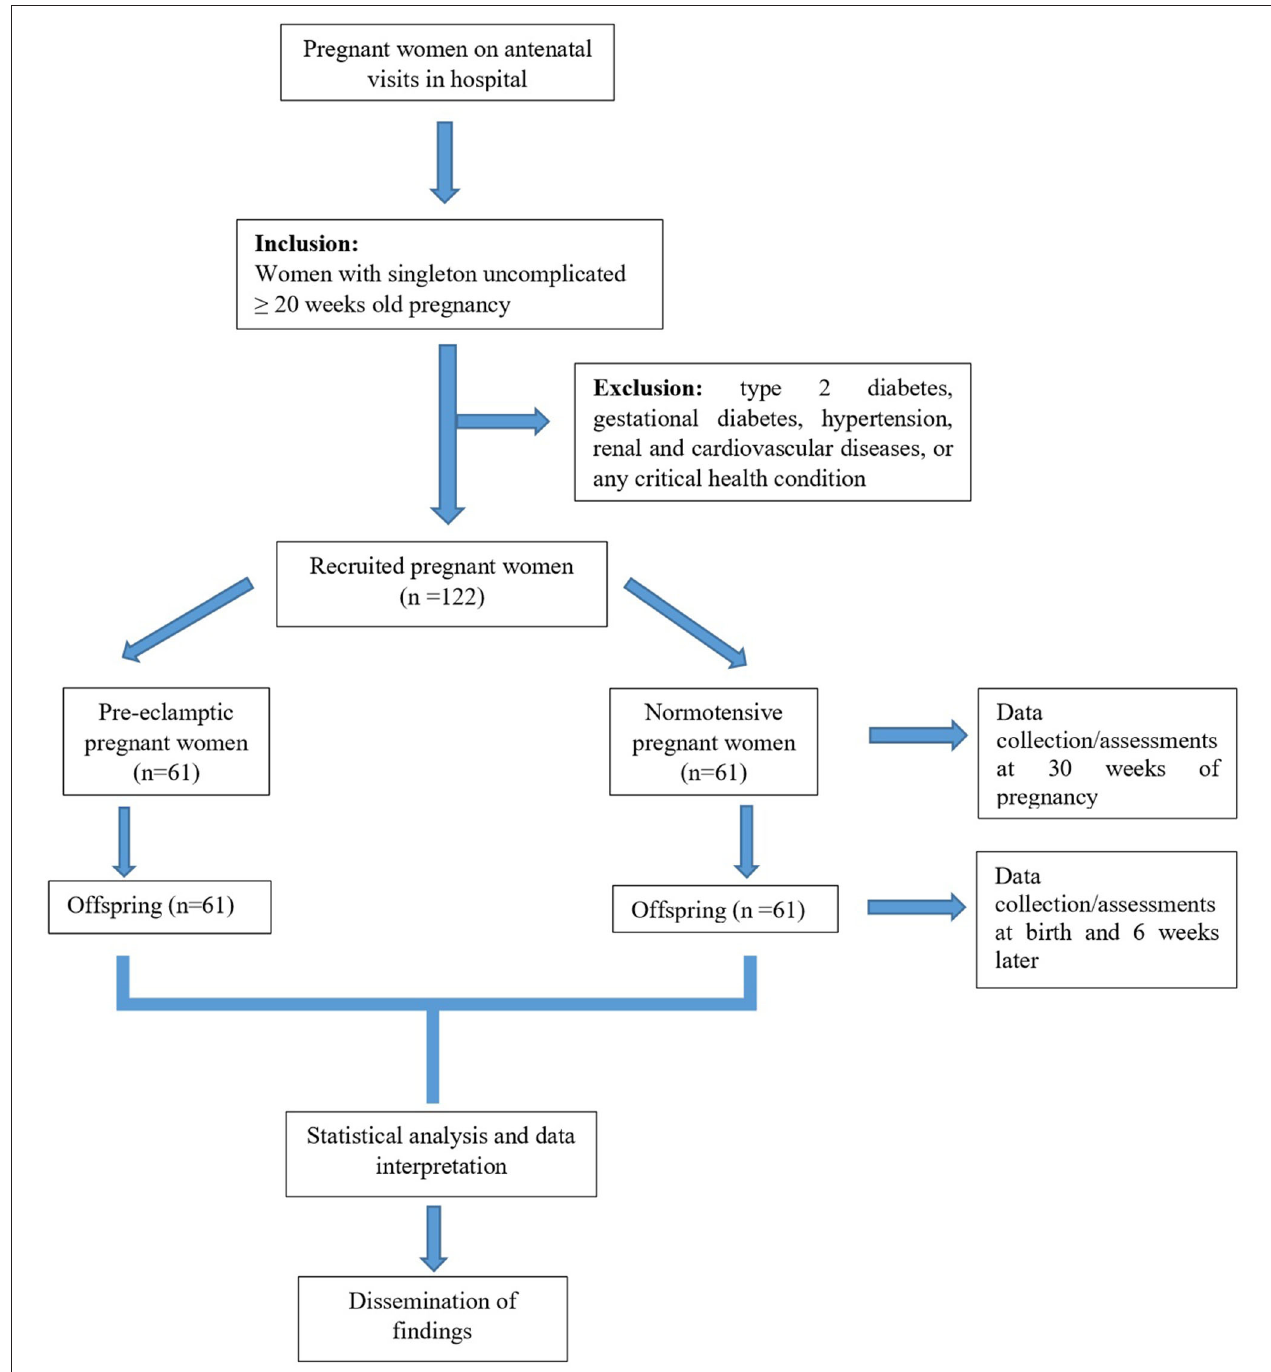
FIGURE 1 | Study design flow chart.